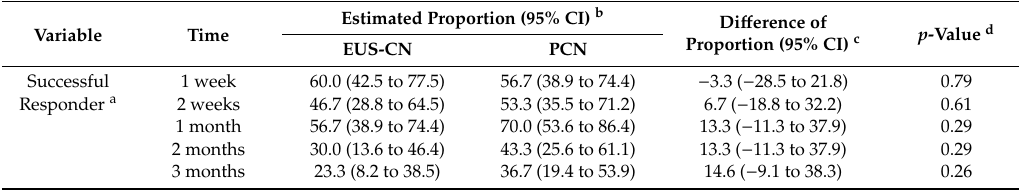
Table 3. Successful pain response after EUS-CN or PCN.